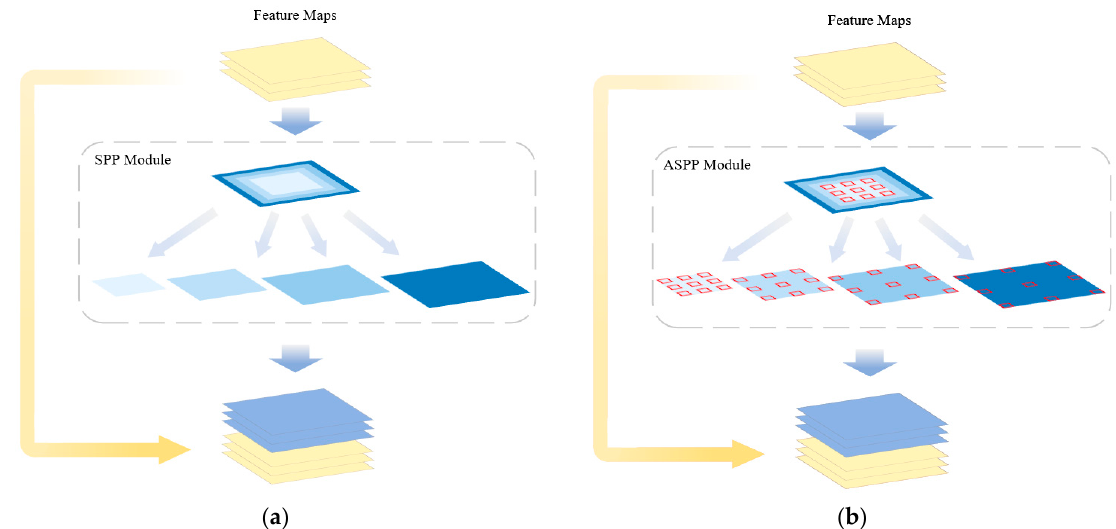
Figure 5. SPP and ASPP module comparison. ( a ) SPP module. ( b ) ASPP module.